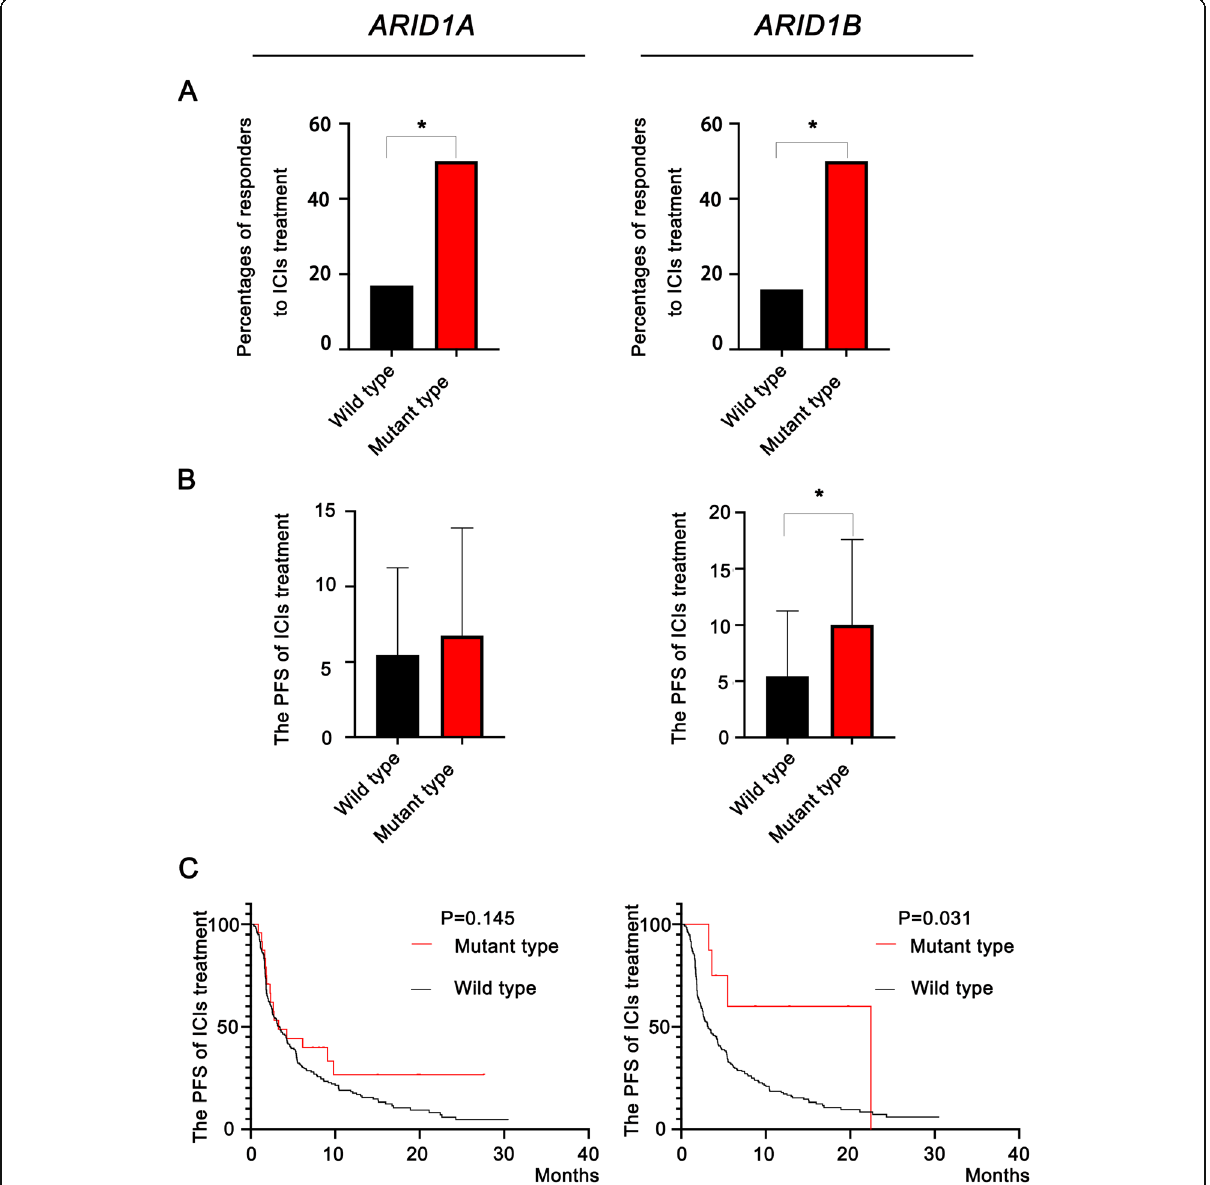
Fig. 2 Mutations in ARID1 subunits predict an improved prognosis for cancer immunotherapy. a The different percentages of patients who responded (complete response+partial response+stable disease) to immune checkpoint inhibitors (ICIs) grouped by the genomic signatures of ARID1 subunits; b . The different progression-free survival (PFS) times grouped by the genomic signatures of ARID1 subunits; c . The survival curves for ICIs- treated patients based on the genomic signatures of ARID1 subunits. (*: P